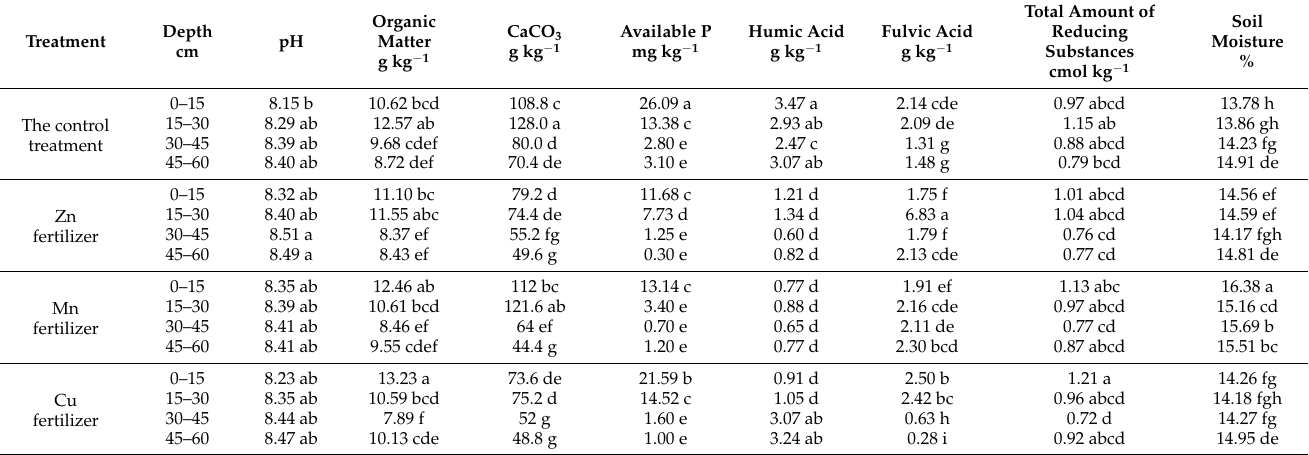
Table 1. Soil properties after 31 years of continuous application of micronutrient